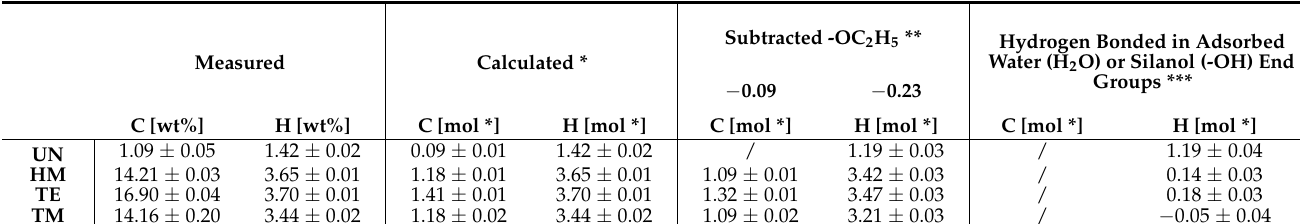
Carbon and hydrogen content in the specimens studied in this work: unmodi- fied UN, the hexamethyldisilazane-modified HM, the triethylchlorosilane-modified TE, and the trimethylchlorosilane-modified TM. The details are given in the